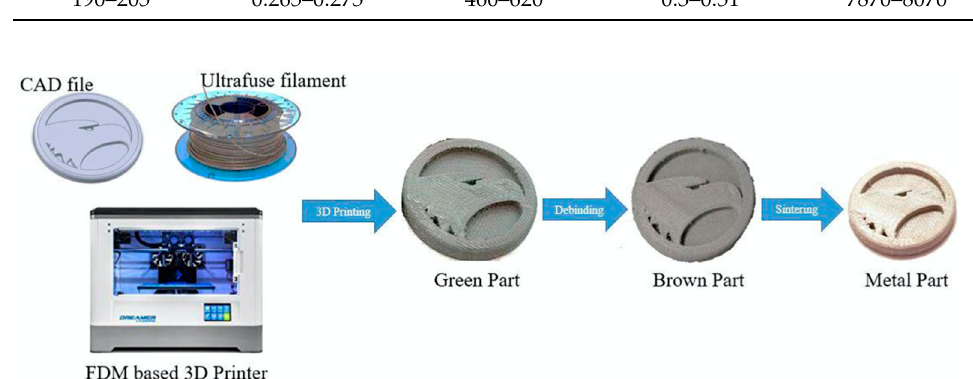
Figure 4. Schematic of Ultrafuse 316L printing process [23]. Table 1. Material properties of 316L steel [9].